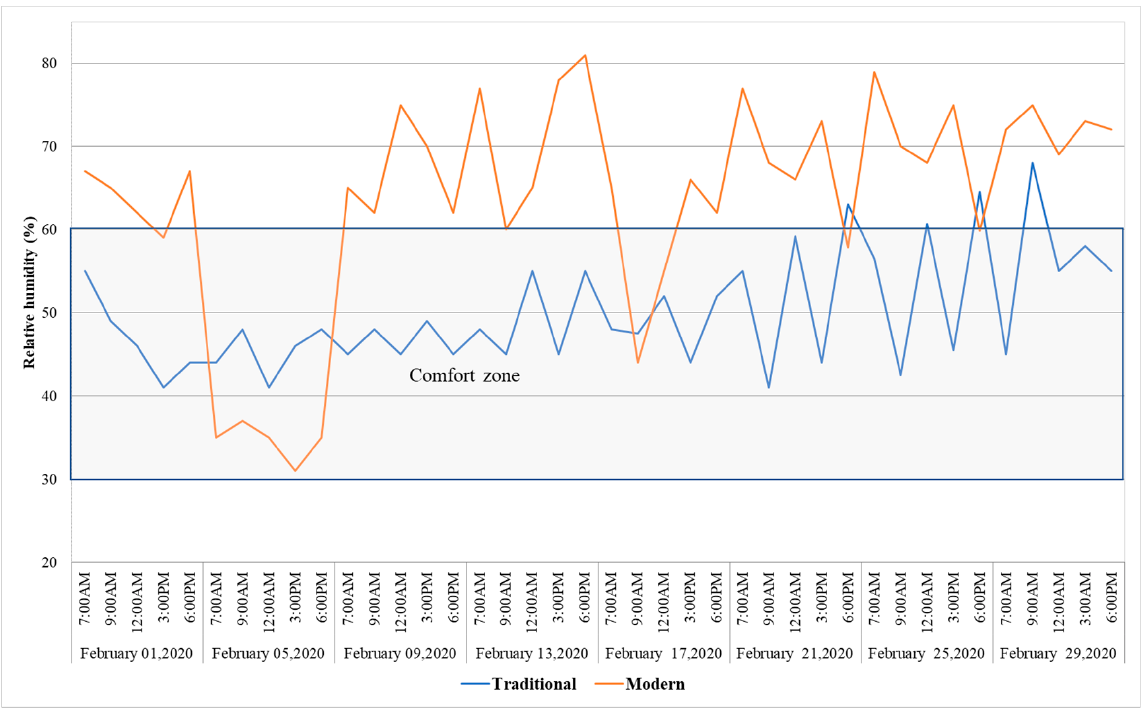
Figure 23. Humidity data from February 2020.